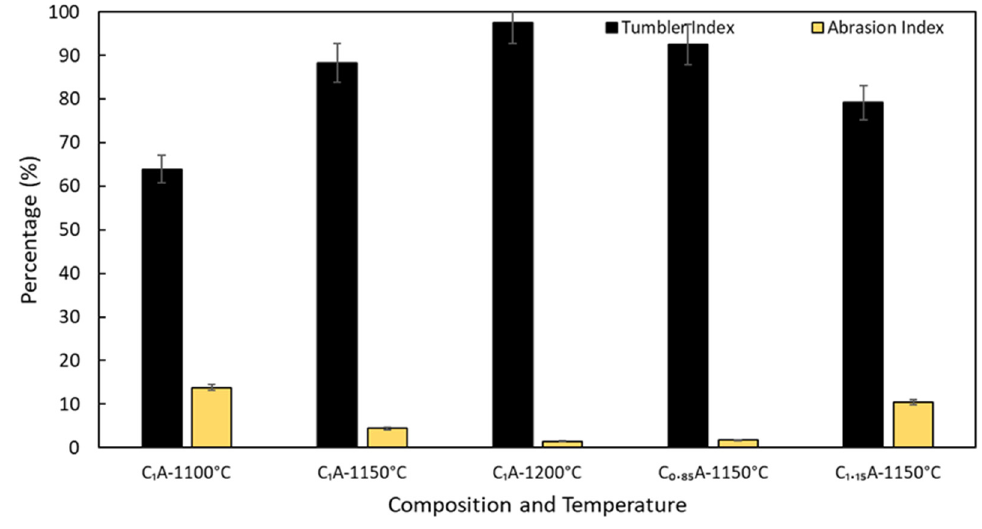
Figure 3. Tumble and abrasion indexes of sintered pellets.